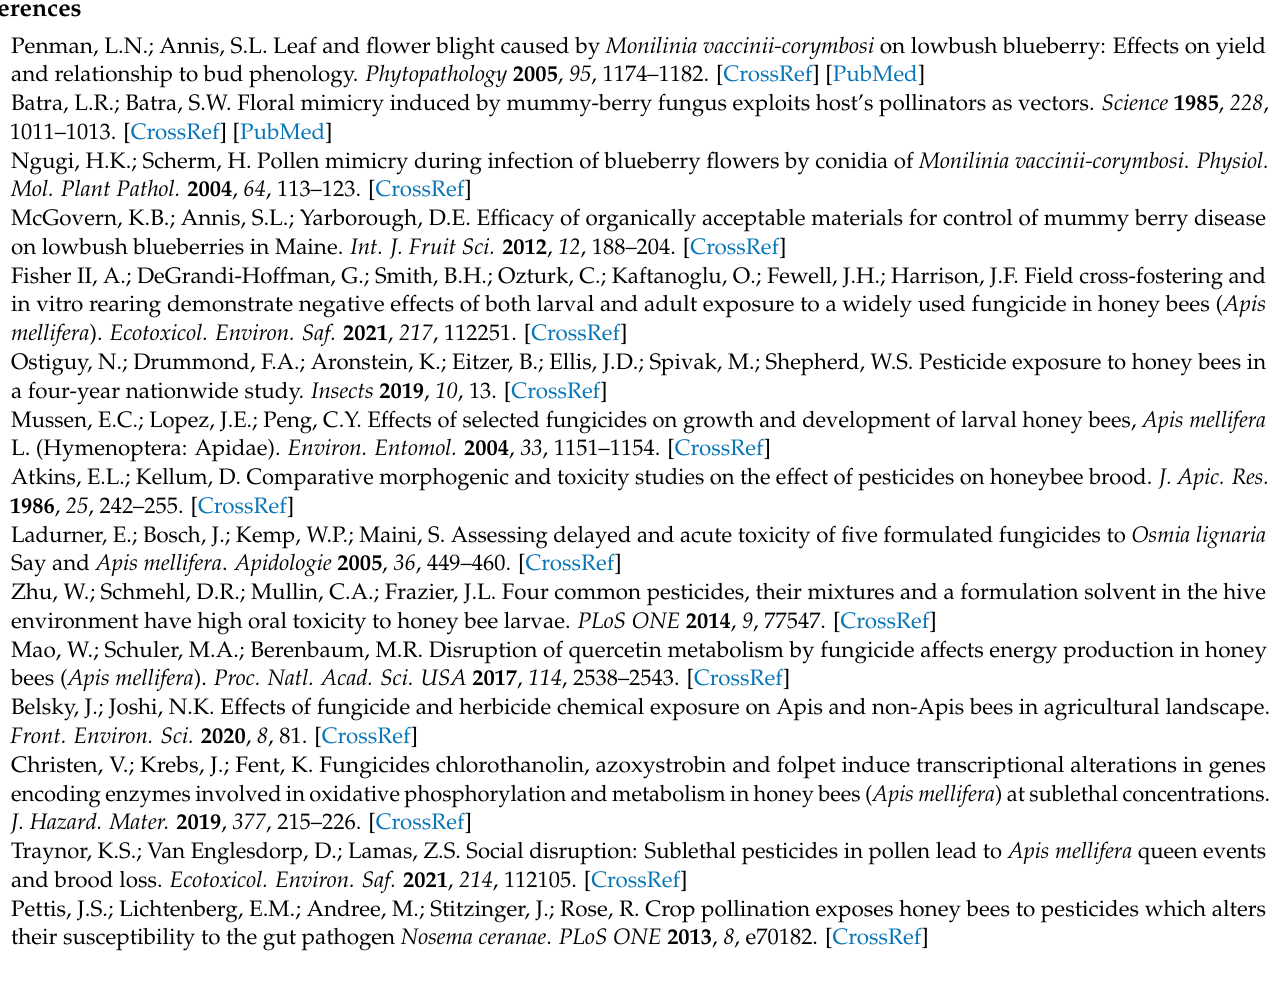
Figure A1. Pathogens ( A ) and mite parasite ( B ) intensity from 2011 to 2013. See methods for details on detection (molecular methods and collections) and quantification. Error bars are standard errors across years. Statistical effect tests were based upon MANOVA. Abbreviations for viruses in x-axis label ( A ) are defined as: BQCV: Black queen cell virus, DWV: Deformed wing virus, SBV: Sac brood virus, IAPV: Israeli acute paralysis virus, KBV: Kashmir bee virus, and CBV: Chronic bee paralysis virus.